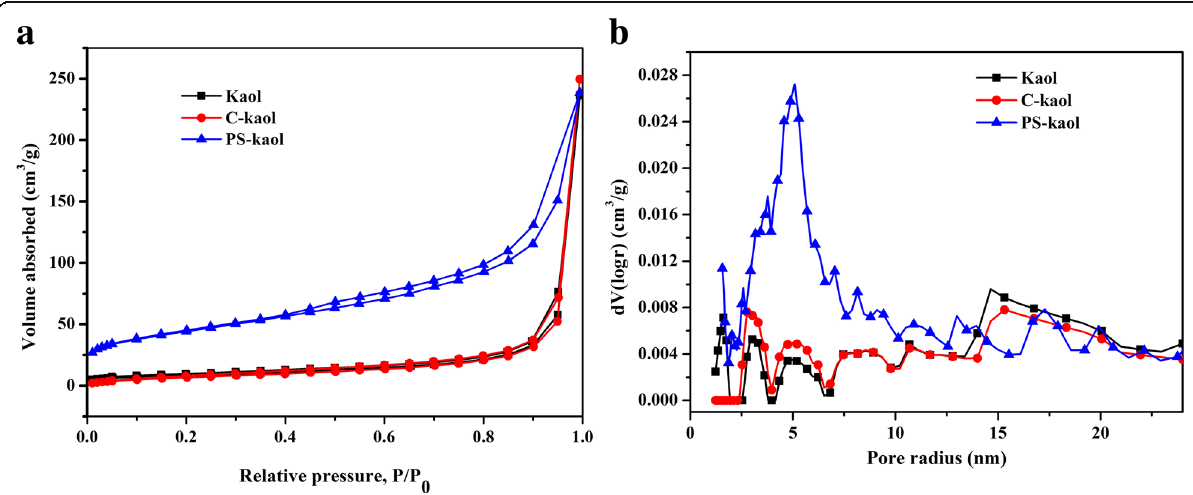
Fig. 3 Nitrogen adsorption-desorption isotherms ( a ) and DFT pore size distribution curves ( b ) of Kaol, calcined Kaolinite (C-Kaol), and the hydrothermal treatment calcined Kaolinite